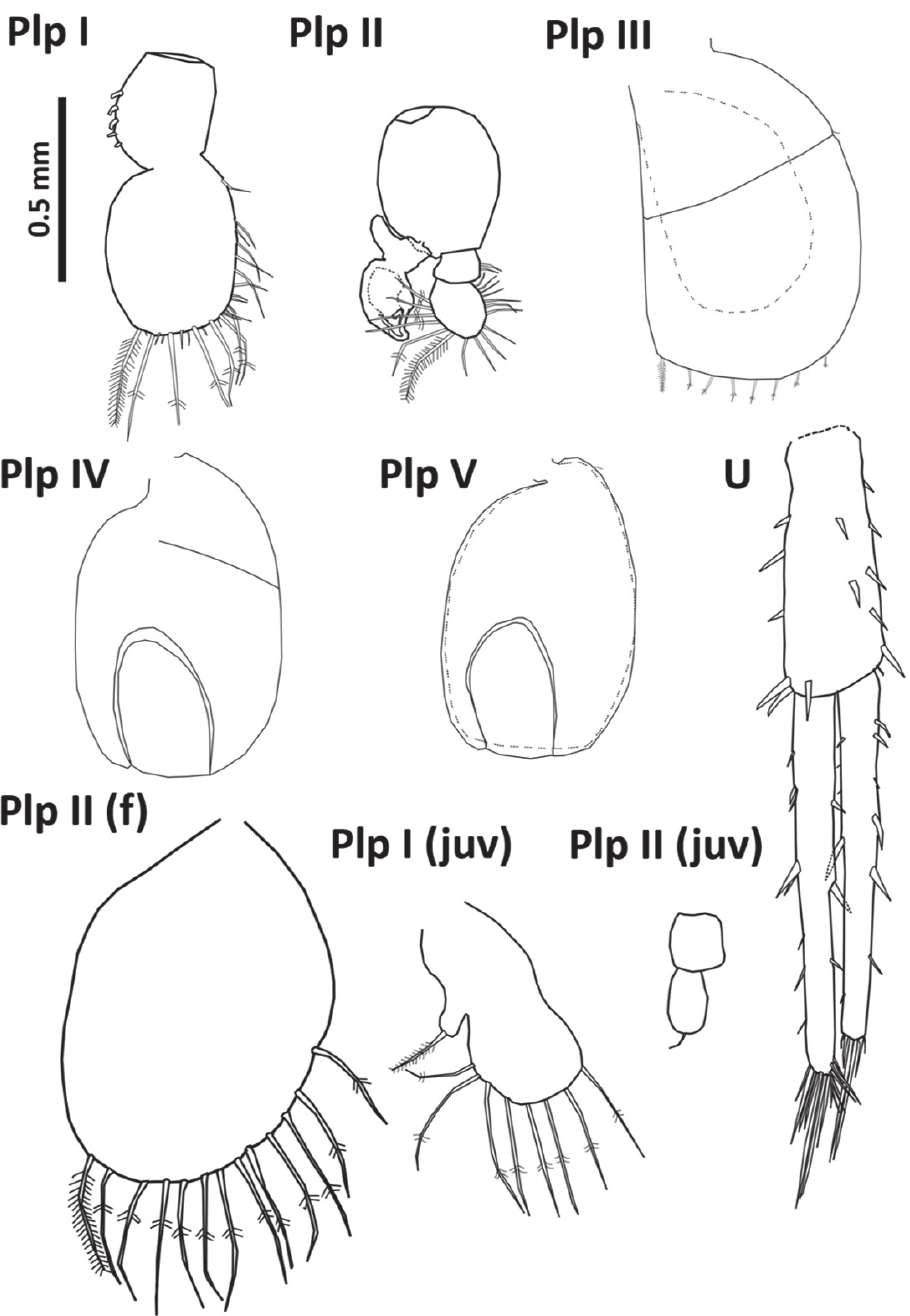
Figure 6. Asellus ismailsezarii sp. nov., Ganow spring, Western Iran. Holotype male, 8.2 mm: Plp I, II; II, IV, V – pleopods I, II, III, IV, IV; U – uropod (pleopod VI). Female, 8.1 mm: Plp II (f) – pleopod II. Juvenile male, 7.3 mm: Plp I, II (juv) – pleopods I,